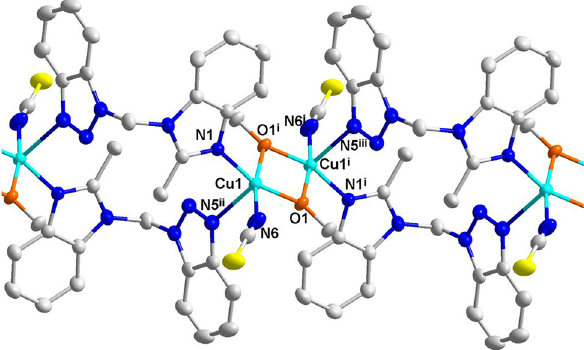
Table  : Data collection and